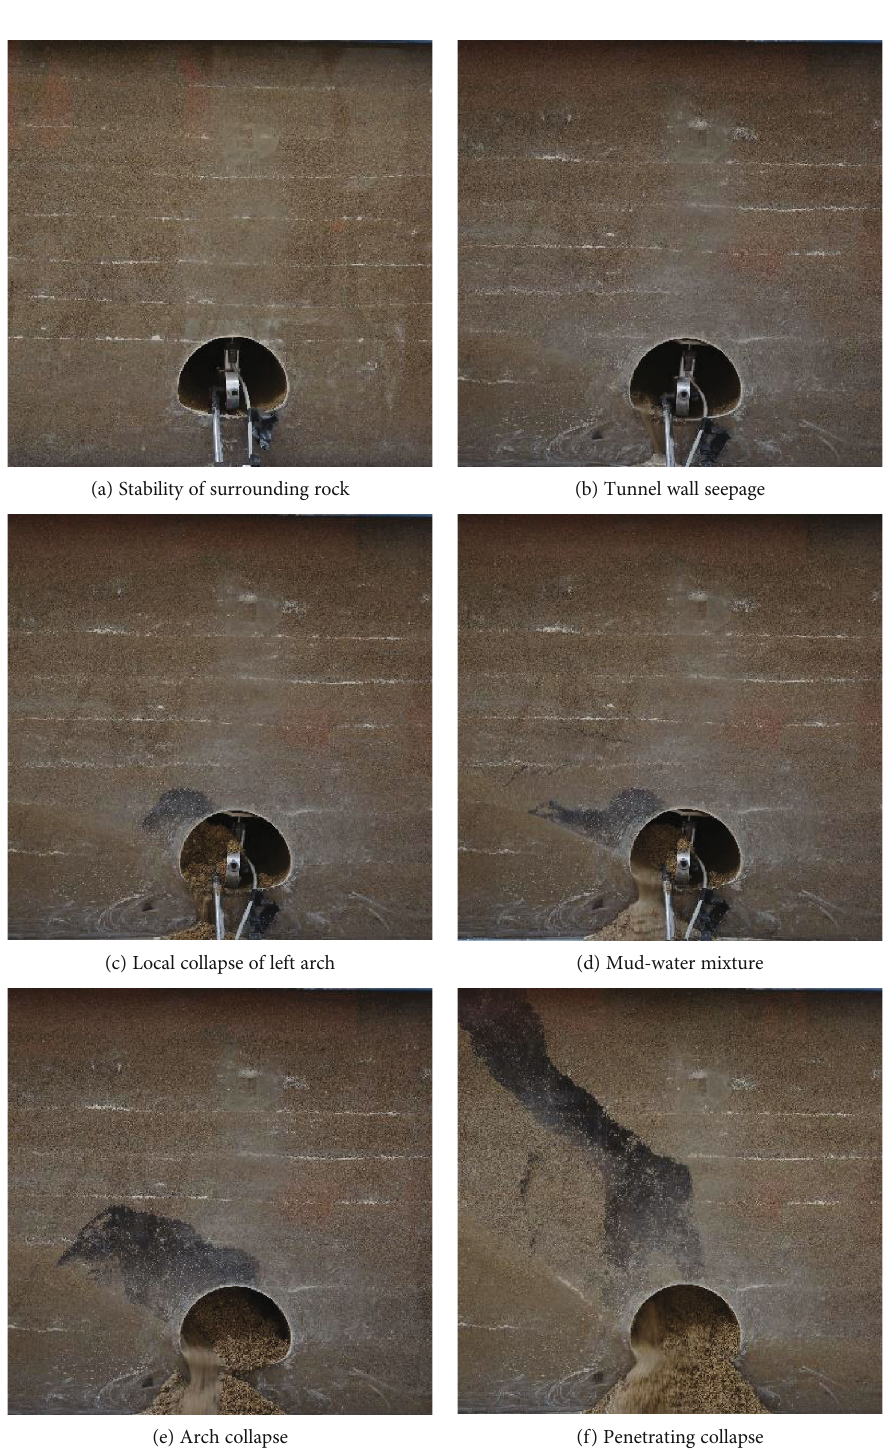
Figure 10: Processes of water inrush in